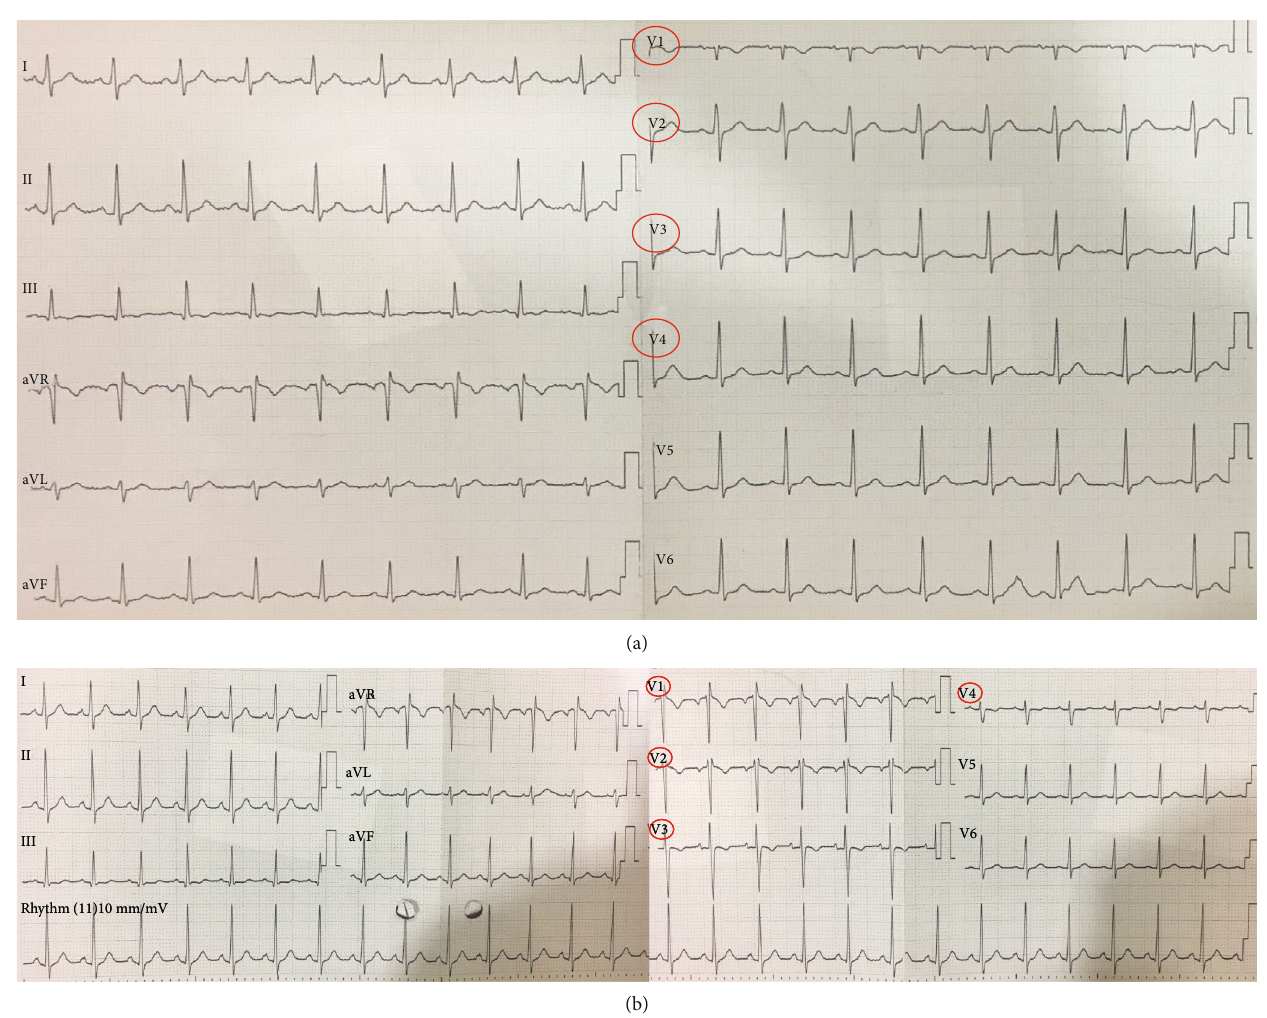
Figure 2: (a) EKG on admission. (b) After